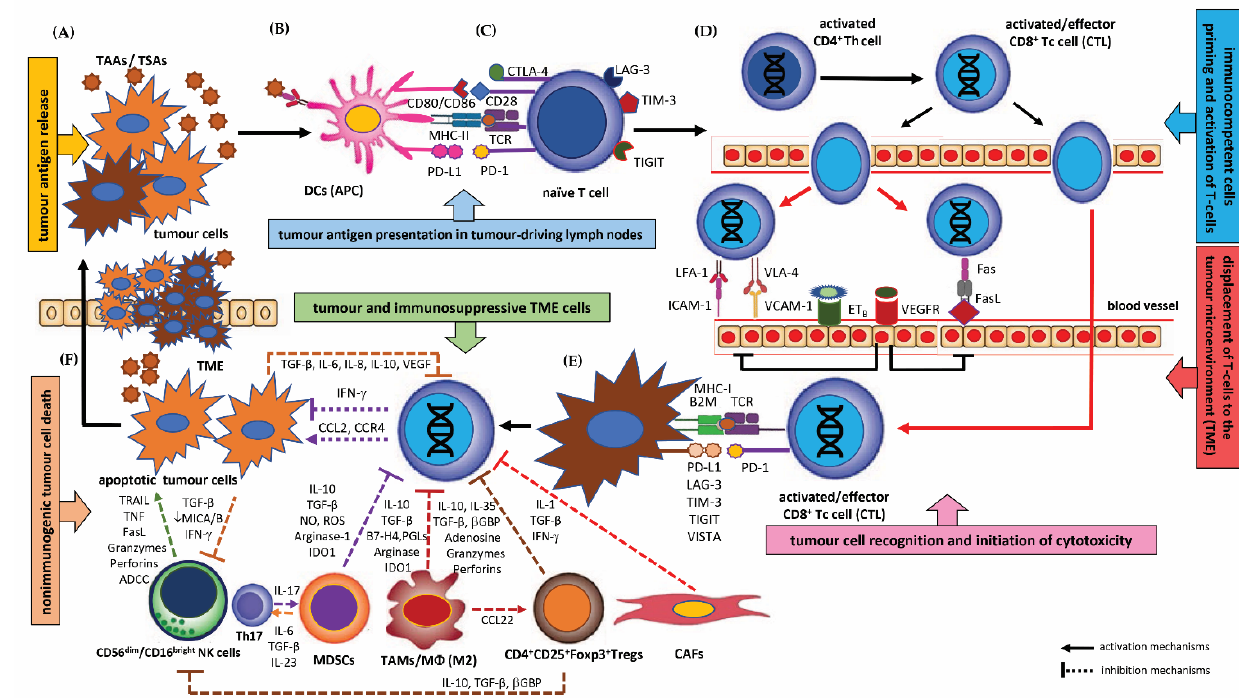
Figure 1. The cancer immunity cycle and the steps in cancer immunoediting. ( A ) Immunogenic cell death and tumour antigen release from the neoplastic cells, ( B ) antigen processing and presentation by antigen presenting cells (APCs), i.e., dendritic cells (DCs) to naïve immune cells in tumour-draining lymph nodes, ( C ) immunocompetent cells priming and activating T cells in the local lymph nodes, ( D ) displacement of T cells to the tumour microenvironment (TME) via the blood stream and infiltration to the tumour, ( E ) recognition of tumour cells by immune cells, ( F ) T cell mediated immune response and killing of cancer cells; abbreviations: TAAs/TSAs: tumour-associated antigens/tumour-specific antigens, CTLA: cytotoxic T cell antigen 4, also known as CD152 (cluster of differentiation 152), CD80/CD86: costimulatory molecules CD80 (B7-1)/CD86 (B7-2), CD28: cluster of differentiation 28, the receptor for CD80 (B7-1) and CD86 (B7-2) proteins, TCR: T